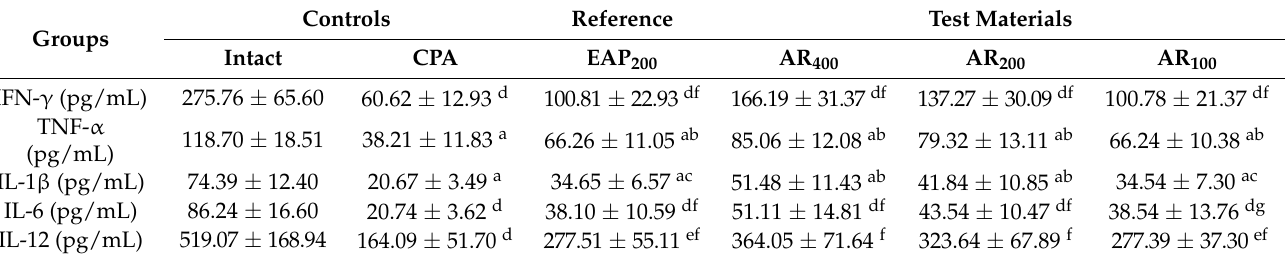
Table 6. Splenic cytokine content in intact and CPA-induced immunosuppressed mice.